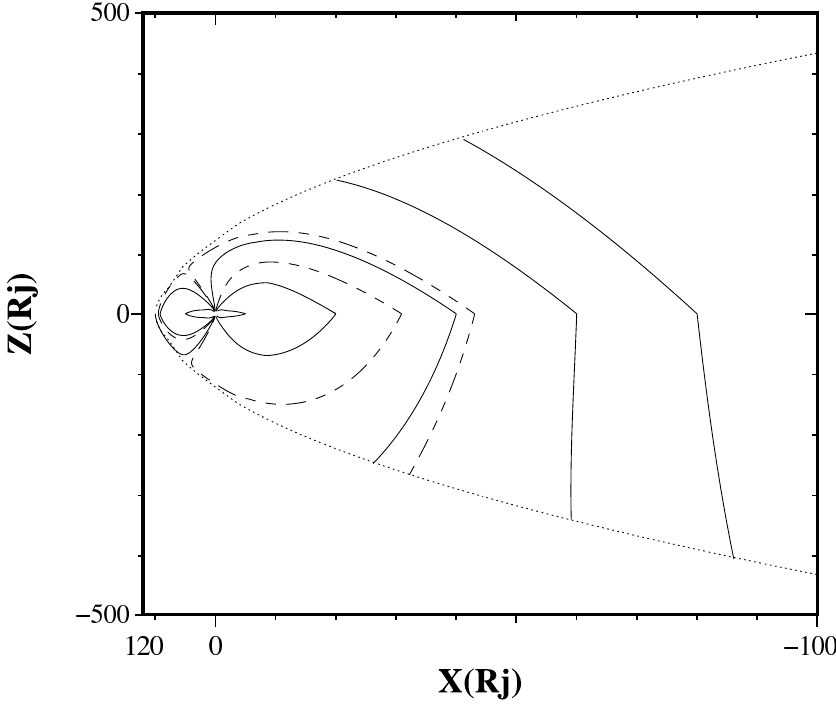
Fig. 3. Noon-midnight meridional cross section of the open Jovian magnetosphere for southward IMF ( B IMFx =− 0 . 26nT; B IMFy = 0nT; B IMFz =− 0 . 5nT) with k J = 0 . 8. The model parameters are: ψ = 0; R ss = 100 R J ; R 2 = 65 R J ; B t =− 2 . 5nT; R D 1 = 92 R J ; R D 2 = 18 . 4 R J ; B DC = 2 . 5nT. Dashed curves separate magnetic field lines of different topology types (closed, open, and the interplanetary magnetic field lines penetrating into the